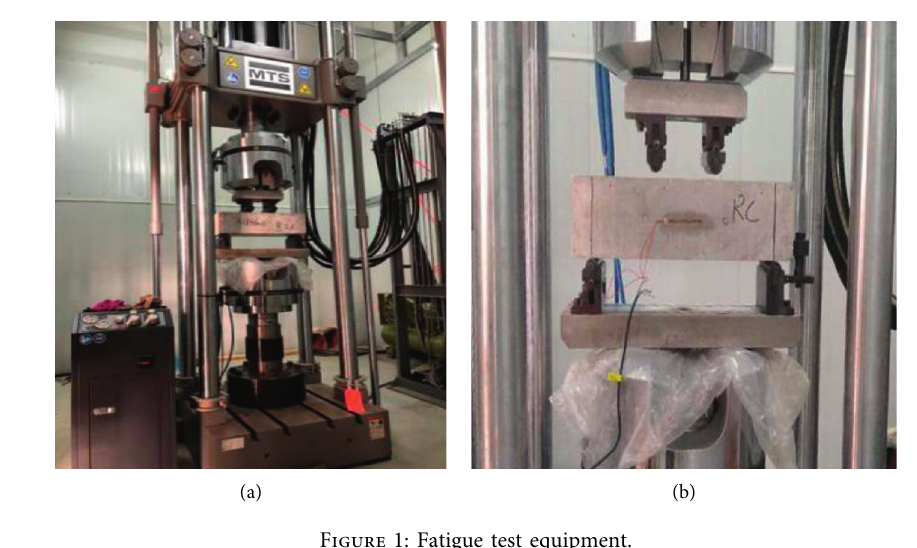
Figure 1: Fatigue test equipment.